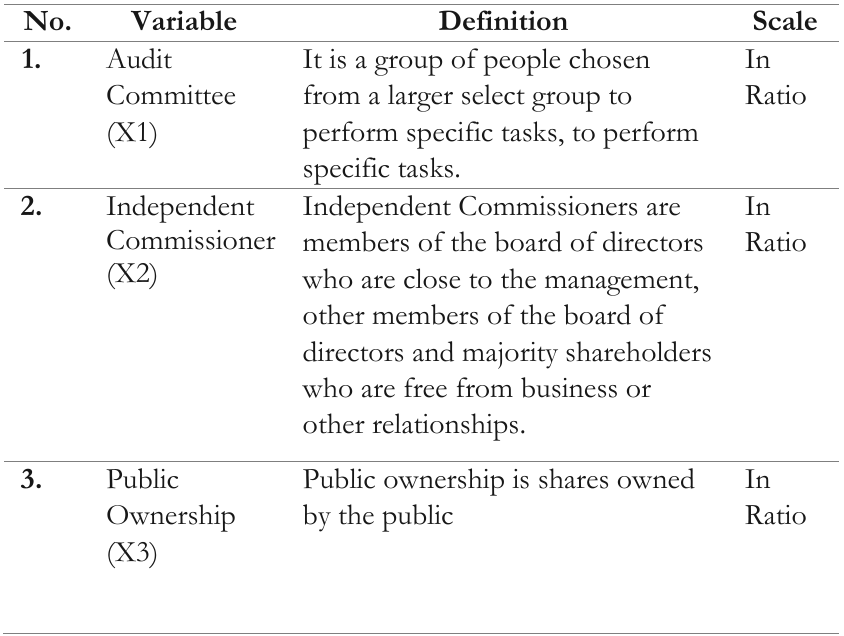
Table 3 Operational